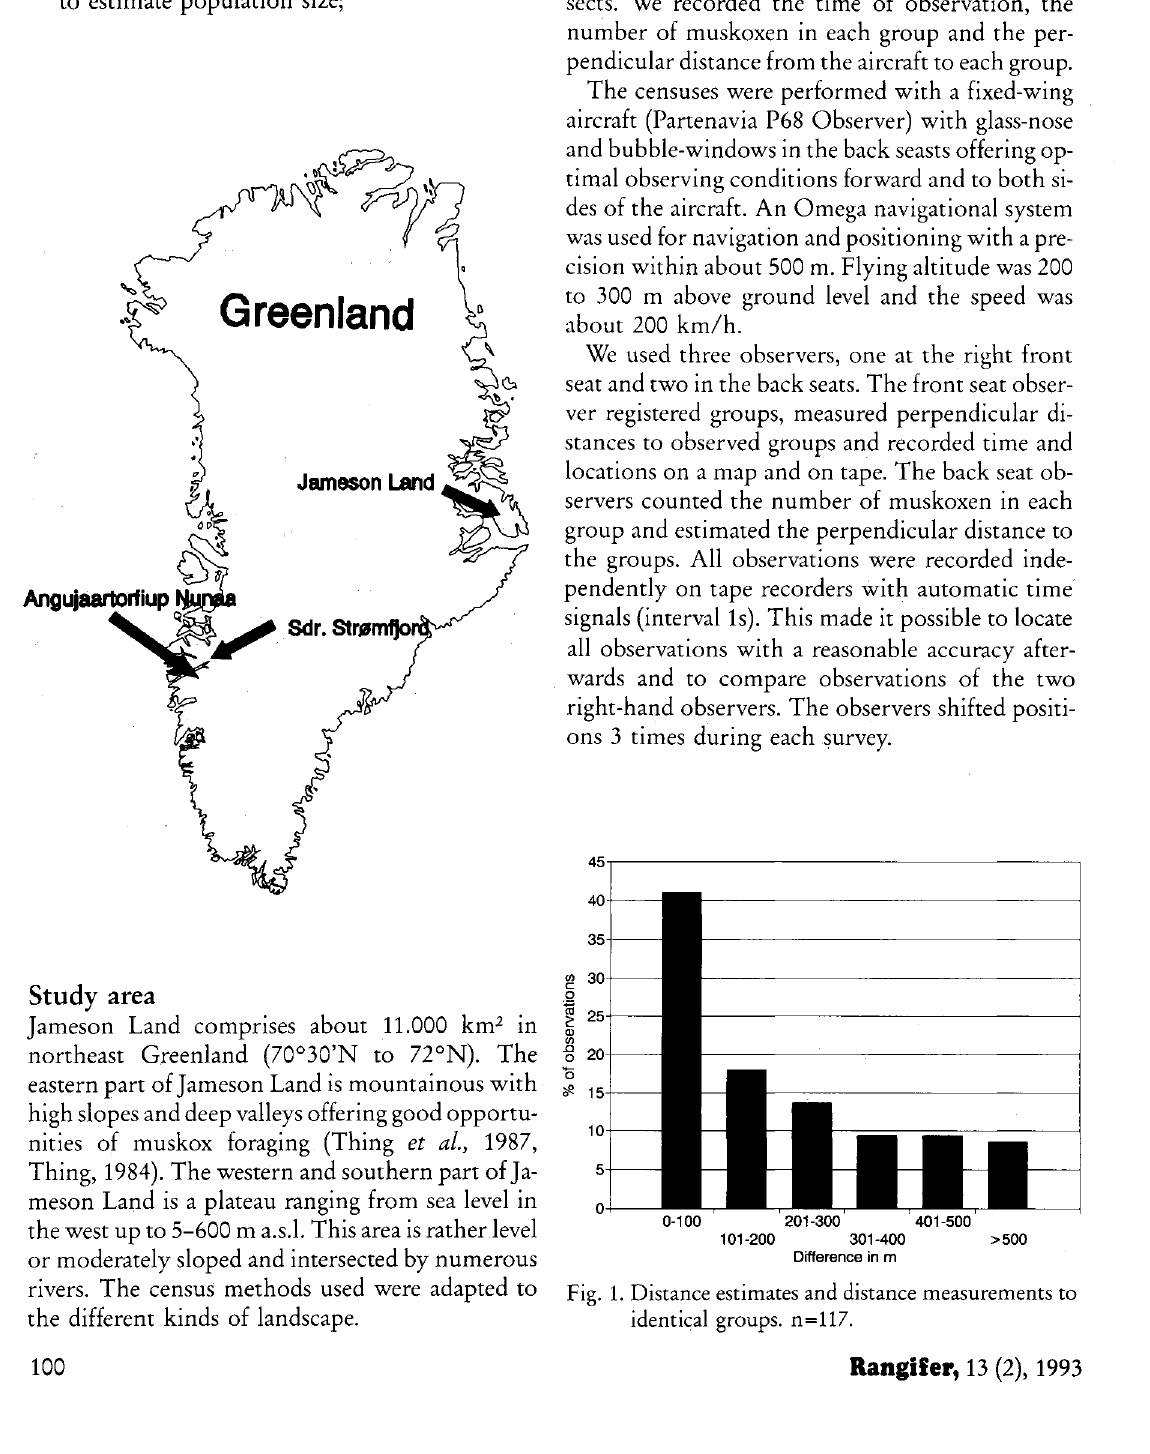
Fig. 1. Distance estimates and distance measurements to identical groups.